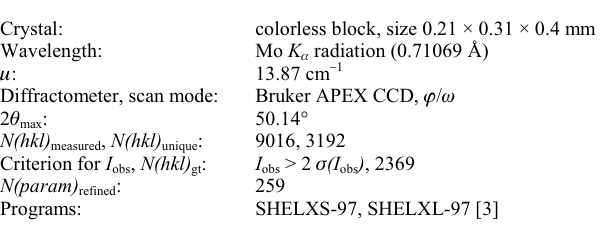
Table 1. Data collection and handling.